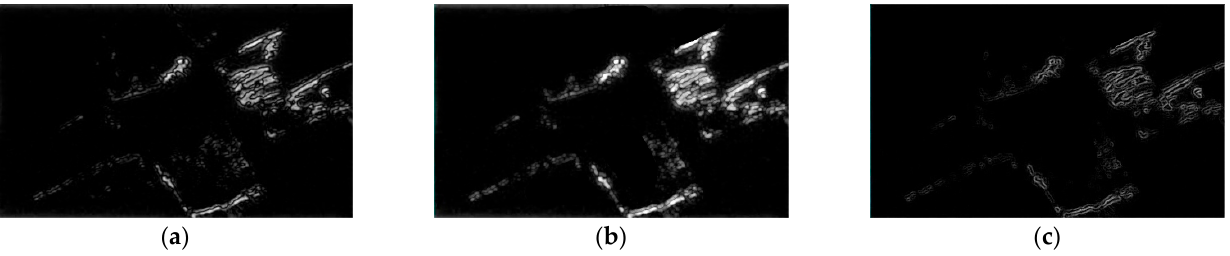
Figure 15. The images resulting from the morphological processing: ( a ) scratch original; ( b ) scratch chart after opening operation chart; ( c ) scratch pattern edge.